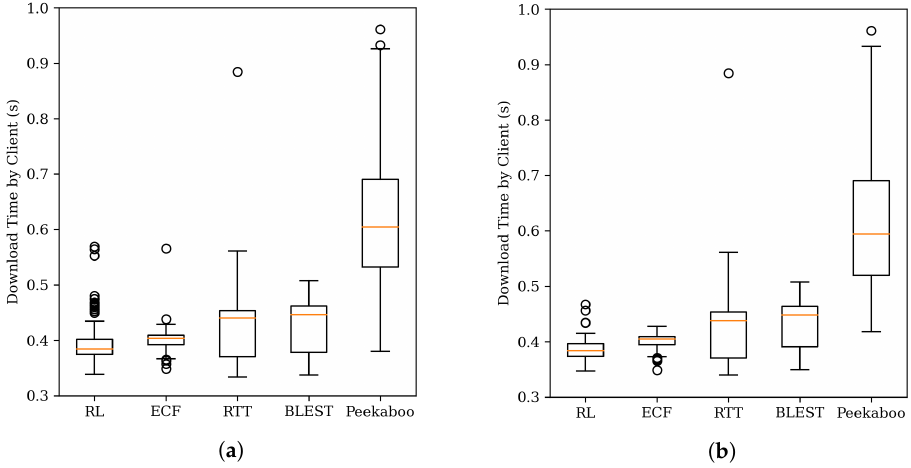
Figure 6. Chunk download times for static network. ( a ) All segments. ( b ) Segment after 150 s.